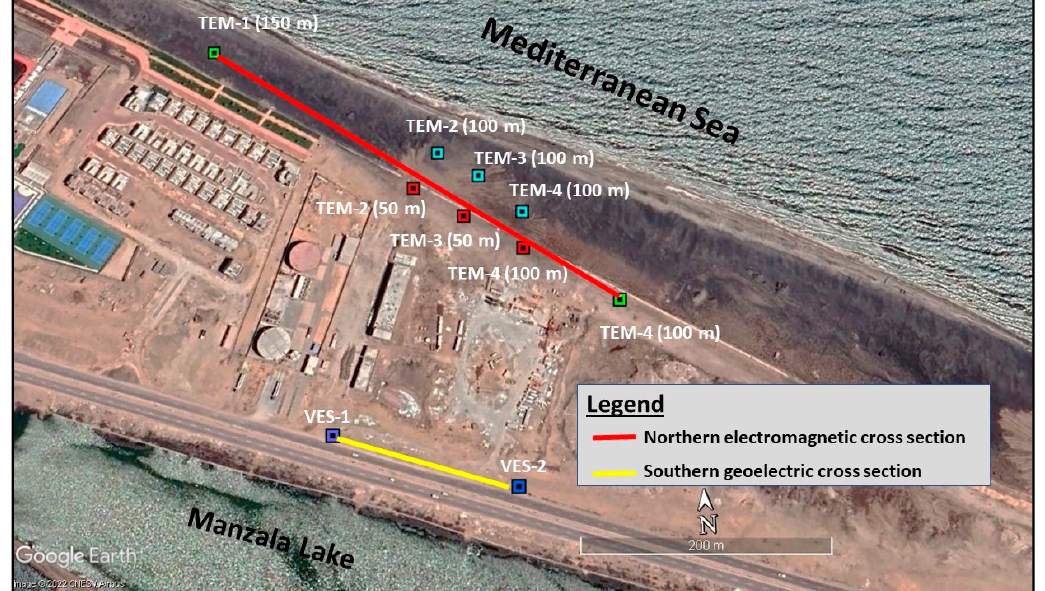
Figure 4. Map represents the locations of VES and TEM measurements and their cross-sections within the study area.